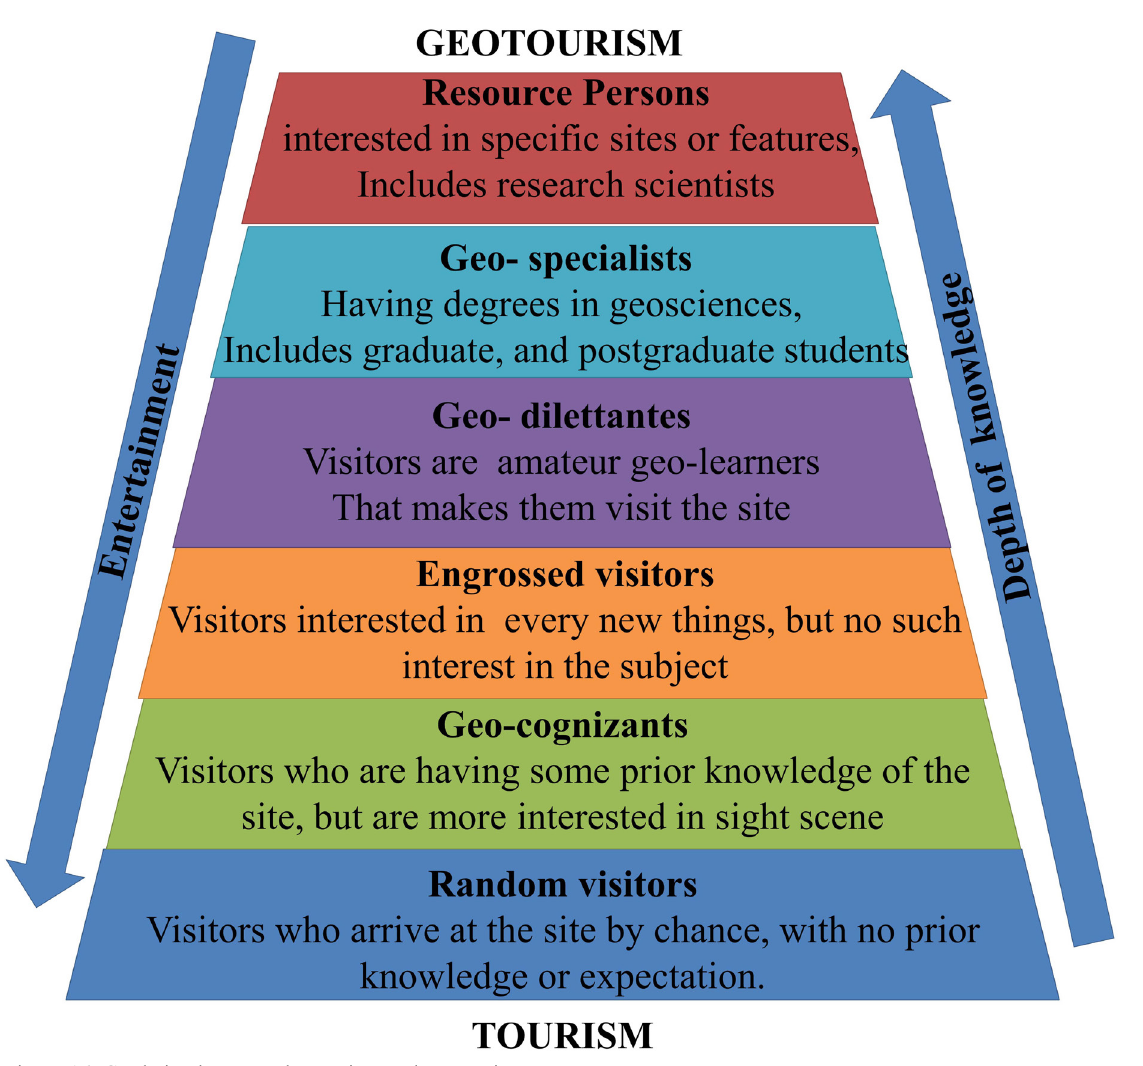
Figure 16. Gradation between the tourism and geotourism